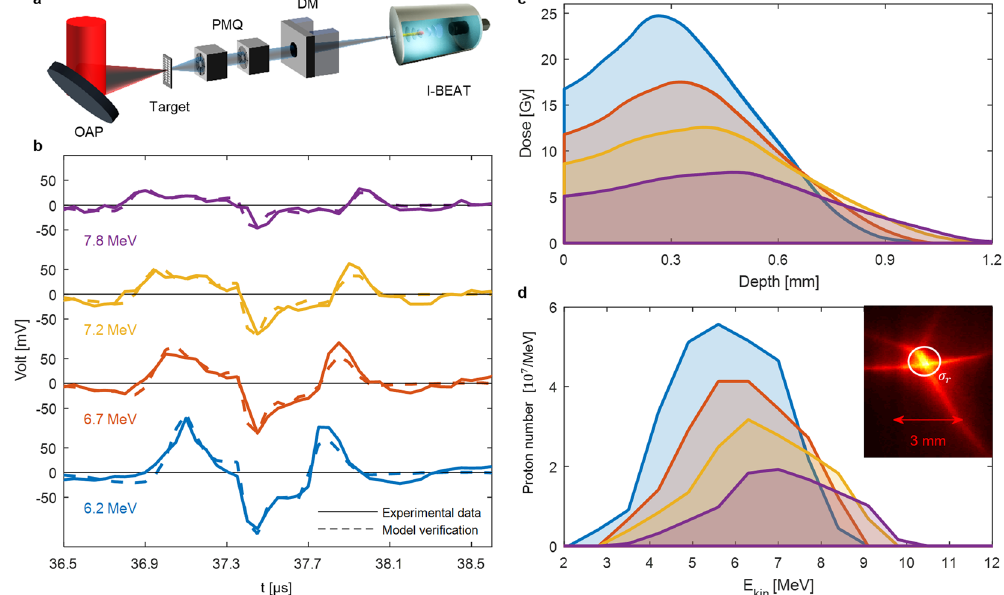
Figure 2. Results for laser-accelerated proton bunches: ( a ) Shows the schematic of the experiment setup. A high power laser (ATLAS-300) is focused with an off-axis parabola (OAP) onto a foil target. Two permanent magnetic quadrupoles (PMQ) are used to focus a short ion bunch. A dipole magnet (DM) is used to remove electrons and low energy ions from the swift ion bunch, which is focused within the ionoacoustic detector. ( b) Acoustic signals of single proton bunches. The design energies attenuated to 6.2, 6.7, 7.2 and 7.8 MeV on entering the water volume, are set by positioning of the PMQs. The solid line is the measured acoustic signal and the dashed line corresponds to the calculated signal from the retrieved spectrum in ( d) . ( c ) Depth dose curves corresponding to the different energy settings. The dose on the central axis is = ⋅ ⋅ . ( d ) D z B z ( ) ( ) s 1 1 ρ πσ 2 r 2 Absolute proton energy distributions of single proton bunches of the different design energy settings in the ion focus. The inset reveals a focal plane image of a single proton bunch at the position of the detector entrance, taken with an image plate. The σ r marks the lateral extension evaluated with